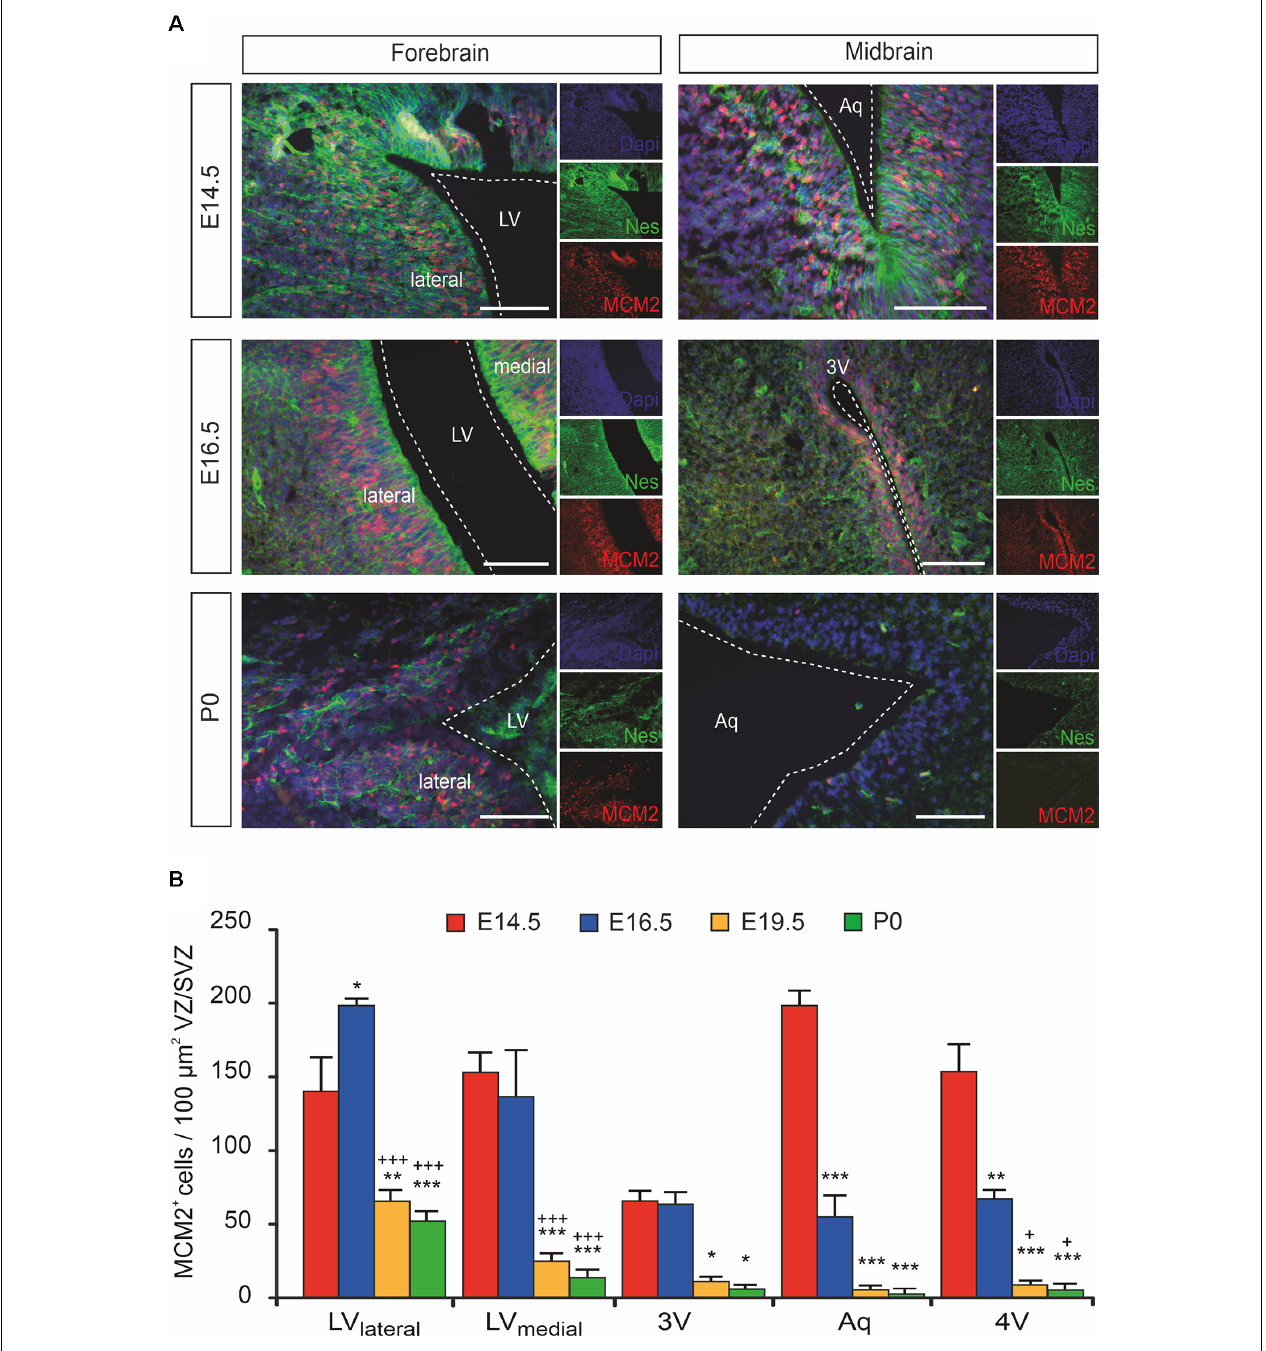
FIGURE 1 | The proliferation of ventricular/subventricular zone (VZ/SVZ) neural stem/progenitor cells (NPCs) within the developing mouse forebrain and midbrain at E14.5, E16.5, E19.5 (quantitative results only), and P0. (A) Proliferating stem/progenitor cells were co-stained with MCM2 (red) and Nestin (green) in VZ/SVZ. Cell nuclei are counterstained with 4,6-diamidino-2-phenylindole (DAPI). Scale bar: 50 µ m. (B) Quantitative immunohistochemistry revealed a dramatic reduction to almost complete loss of proliferating (MCM2 + ) cells during development within the VZ/SVZs except for the lateral VZ/SVZ of the lateral ventricles. Two-way ANOVA with post hoc t -test and Bonferroni adjustment with VZ/SVZ regions and developmental stages as fixed factors revealed that brain regions and embryonic stages had a significant interaction effect on MCM2 + cells per 100 µ m 2 ( P < 0.001, F -value = 5.7) and significant differences among VZ/SVZ regions ( P < 0.001, F -value = 17.1) and embryonic stages ( P < 0.001, F -value = 95.0). P -values from post hoc tests with Bonferroni adjustment are * P < 0.05, ** P < 0.01 and *** P < 0.001 when compared to E14.5 and + P < 0.05 and +++ P < 0.001 when compared to E16.5 (only P -values among developmental stages are displayed for clarity; complete statistics in Supplementary Tables S1A,B ). 3V, third ventricle; Aq, aqueduct; LV, lateral ventricle; LV lateral , lateral wall of the lateral ventricles; LV medial , medial wall of the lateral ventricles; MCM2, mini-chromosome maintenance protein 2; Nes, Nestin.